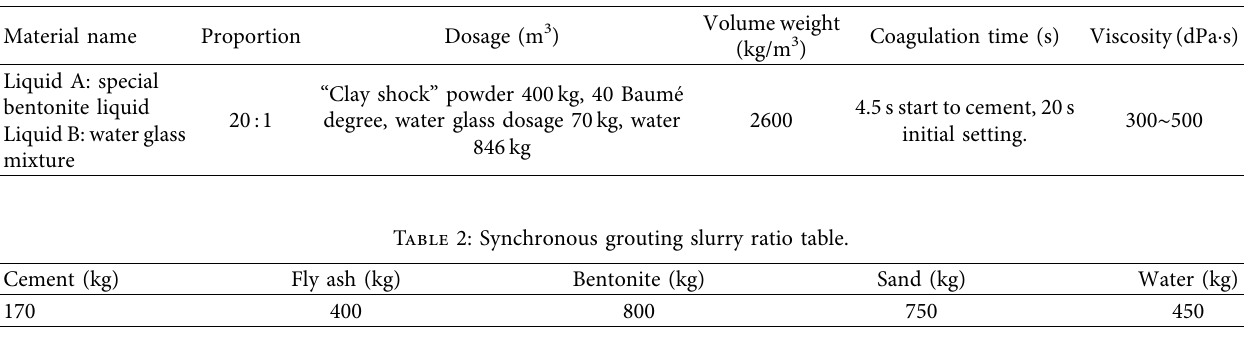
Table 1: The ratio of “Clay shock” grouting.